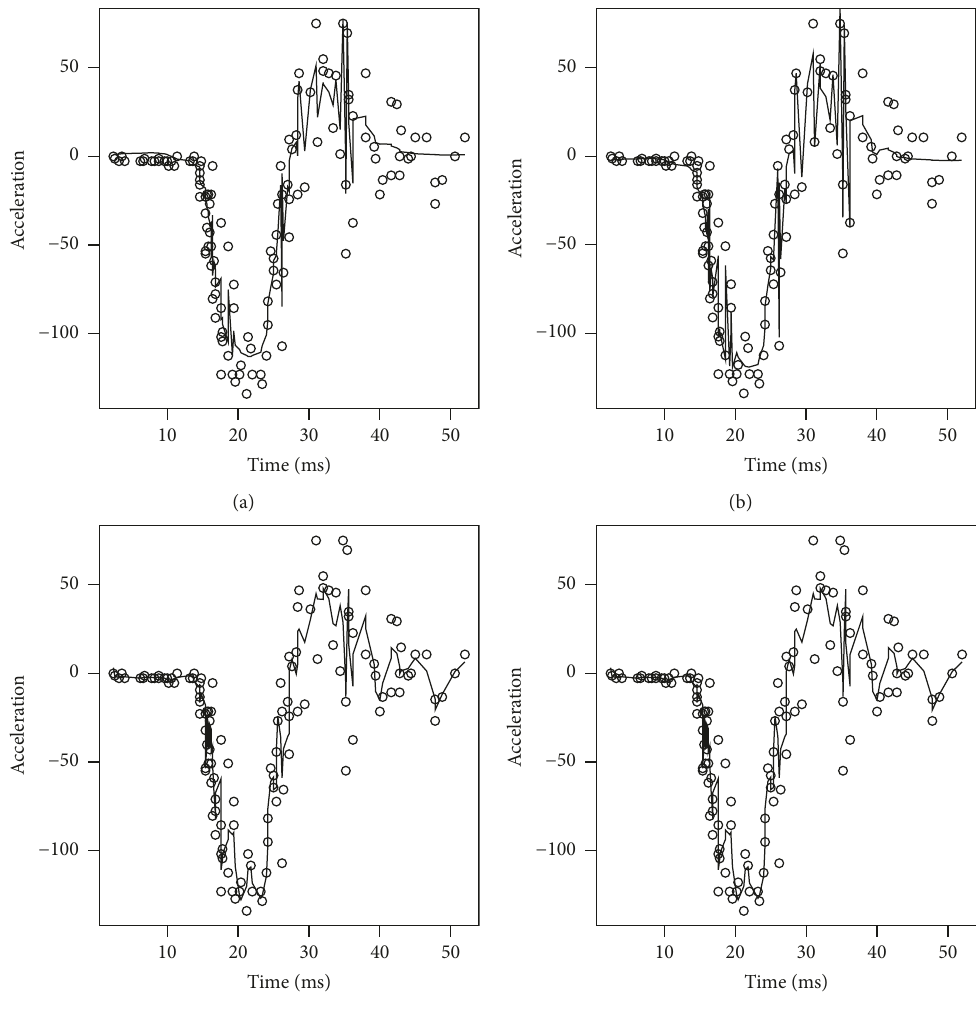
Figure 11: Plots of the reconstructions of thresholding: the panels show reconstruction using; (a) CMWS-hard; (b) CMWS-soft; (c) Model I; and (d) Model